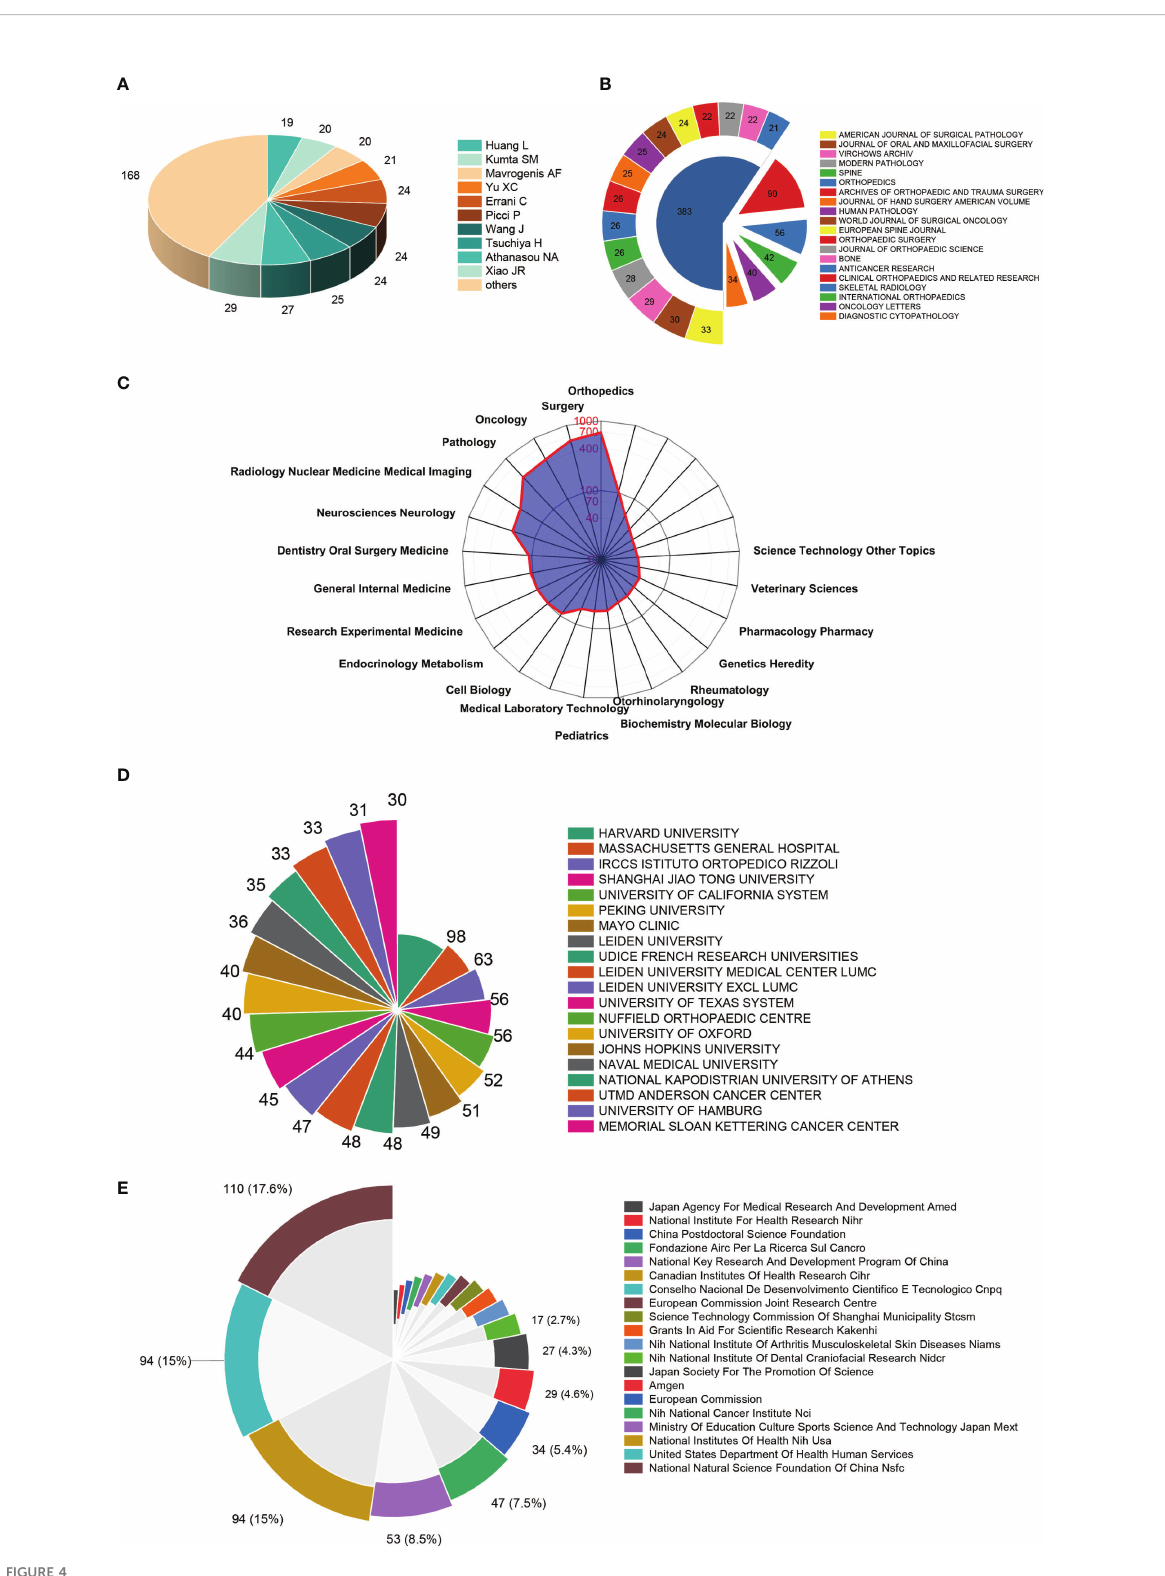
FIGURE 4 High-contribution authors, journals, research orientations, institutions, and funds of global publications about GCTB. (A) The top 10 authors with the most publications on GCTB. (B) The top 20 journals with the most publications on GCTB. (C) The sum of research orientations in the world. (D) The top 20 institutions with the most publications on GCTB. (E) The top 20 funding sources with most publications on